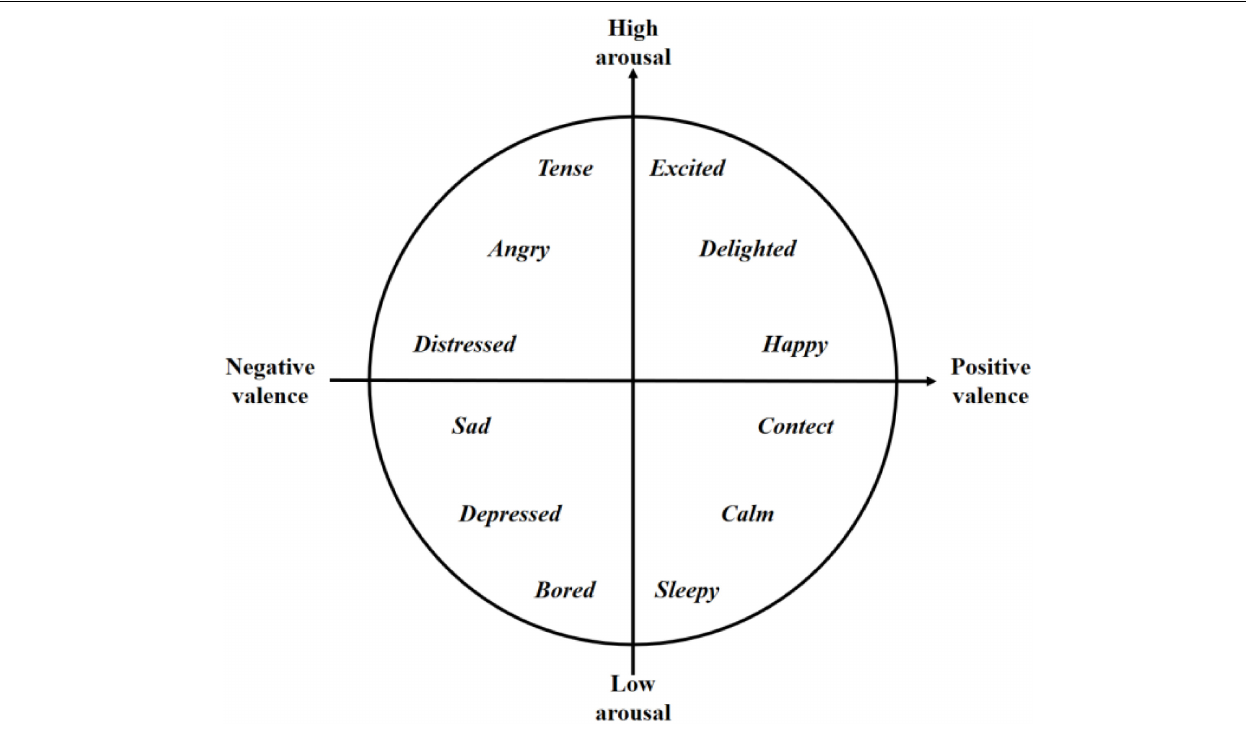
FIGURE 5 | Valence-Arousal model of